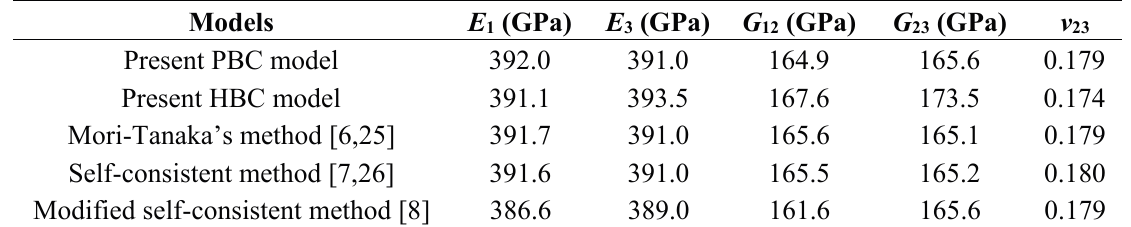
Table 1. Comparison of the present PBC and HBC models with some other theoretical